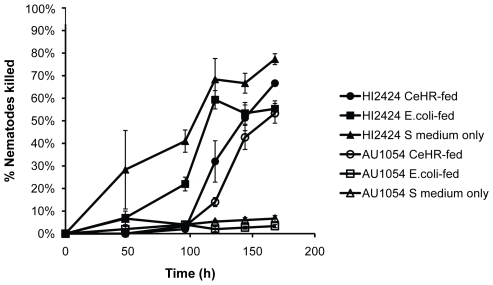
Effect of prior diet on susceptibility.
C. elegans diet prior to encountering B. cenocepacia strains affects its susceptibility to killing. Strain HI2424 (filled symbols) is more lethal to nematodes that had been starved in buffer (triangles) or fed heat-killed E. coli OP50 (squares) than to nematodes that were grown in axenic CeHR medium (circles); strain AU1054 (open symbols) is less lethal to nematodes that had been fed E. coli or starved in buffer, than to nematodes that were grown in axenic CeHR medium. Results are expressed as mean (+/− SEM) of three replicate assays.